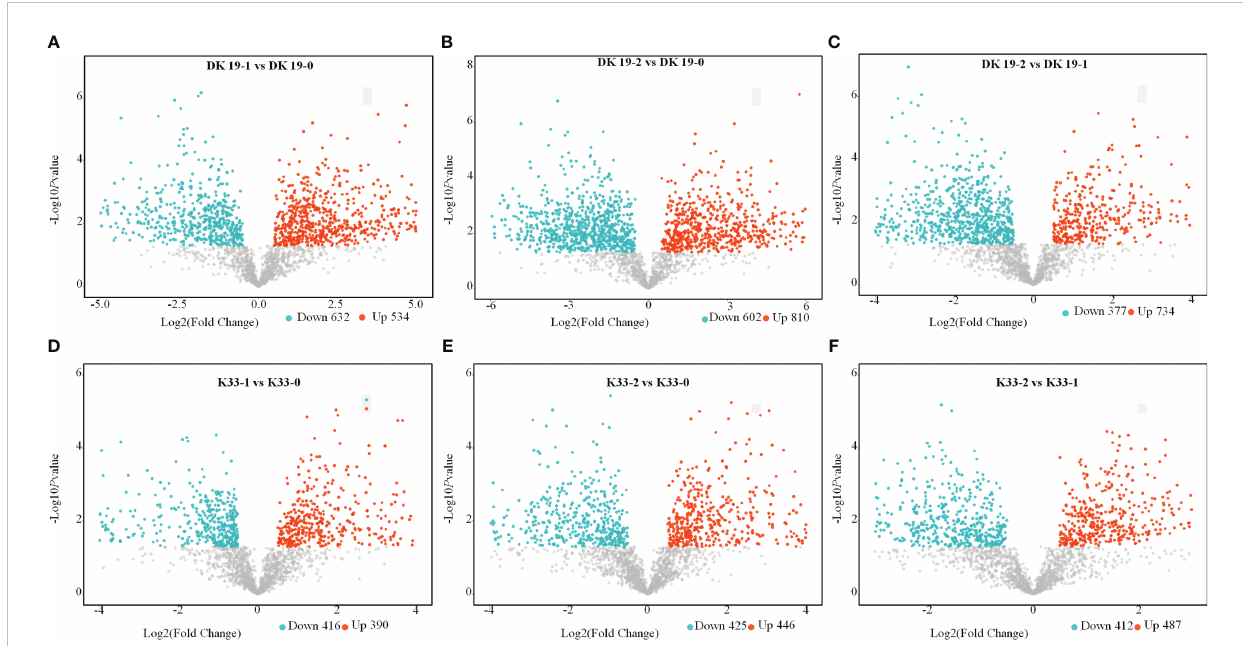
FIGURE 4 Screen of differentially accumulated metabolites (DAMs), generated using untargeted metabolomics sequencing. The volcano plot presents the expression of the DAMs in different treatments, the horizontal axis is Log2 (Fold Change) value, and the vertical axis is - Log10 p value, the red dots represent up-regulated metabolites, and the blue dots represent down-regulated metabolites. (A – C) DAMs in DK19 between different stages of treatment. (D – F) DAMs in K33 between different stages of